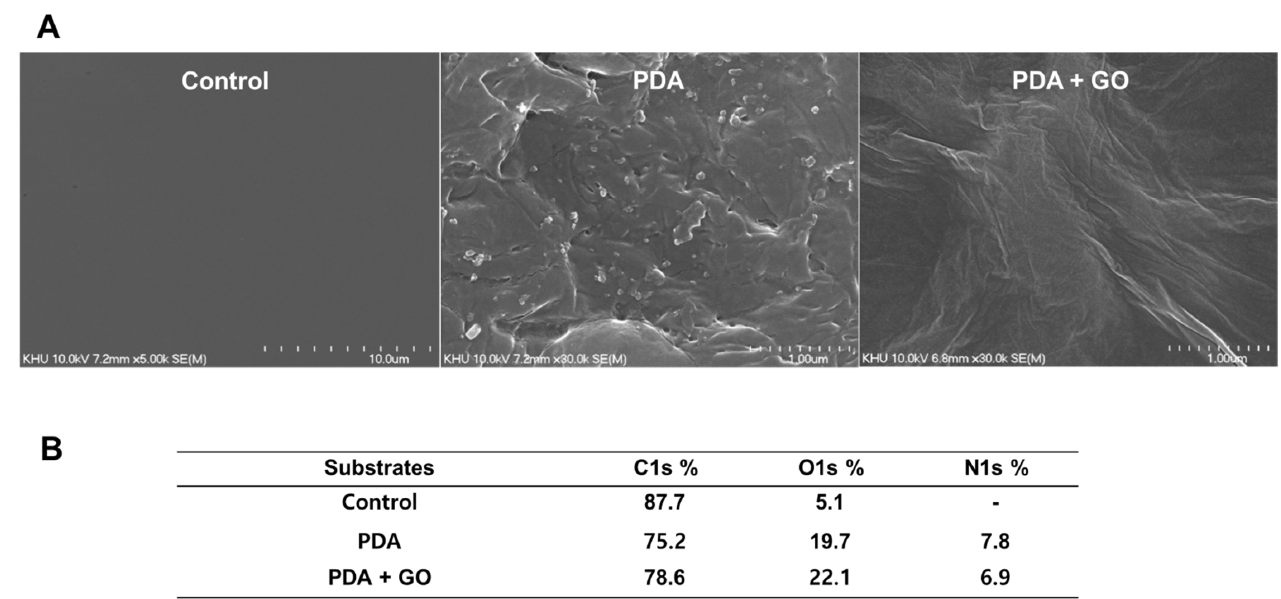
Figure 1. Surface characterization of PDA/GO substrates. ( A ) Topographical features of the PT surface, PDA (1 mg/mL)- coated, and PDA/GO (1 mg/mL + 1 mg/mL)-coated surfaces were assessed by scanning electron microscopy at ×10 k magnification. ( B ) Relative atomic composition of each sample.